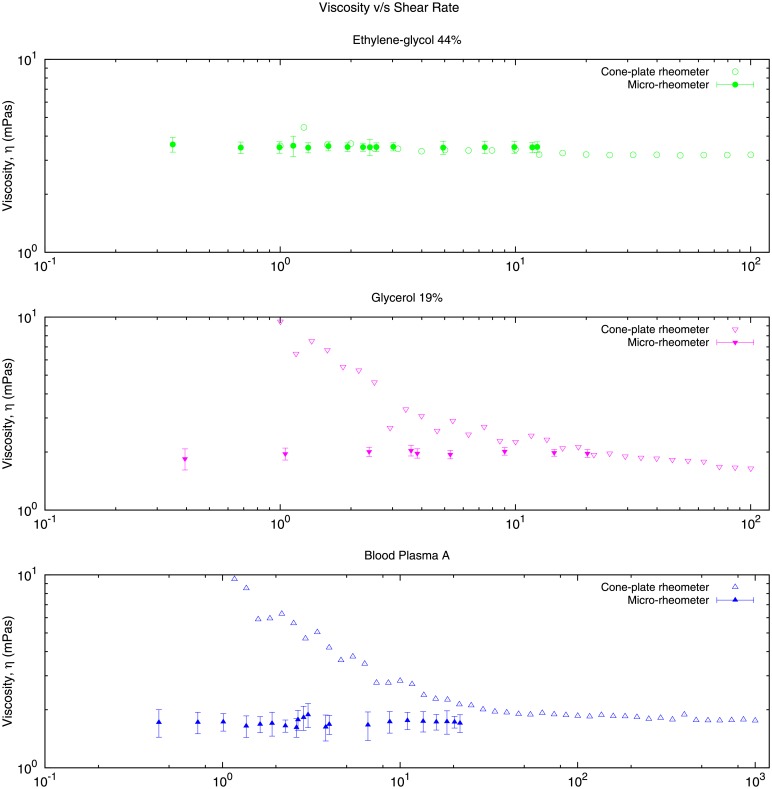
This plot shows experimental values of the viscosity for three Newtonian fluids at low shear rate.We compare the results obtained with our micro-device (solid symbols) to the results produced using a macroscopic commercial cone-plate rheometer (Malvern Kinexus Rotational Rheometer, empty symbols). We observe that the cone-plate rheometer produces spurious results at low shear rates which could be misconstrued as a Non-Newtonian behaviour. By contrast our device is consistent with the Newtonian character of the fluids used in all the range of shear rates.